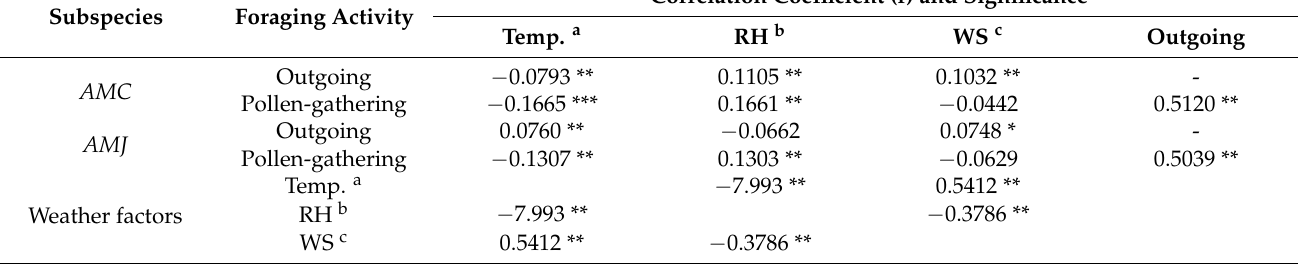
Table 1. Pearson correlation coefficients among weather factors (temperature, relative humidity, and wind speed) and foraging activities (outgoing foraging and pollen gathering activities) of AMJ and AMC . The general means of the two subspecies revealed a positive significant correlation (0.523***) between outgoing foraging and pollen-gathering activities. The asterisks indicate significant correlations (* p < 0.05, ** p < 0.01, *** p < 0.001). a Temperature; b relative